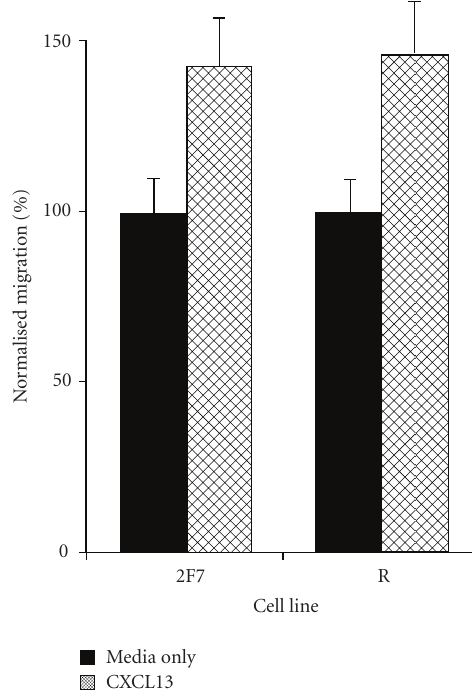
Figure 4: AIDS-NHL cell lines demonstrate chemotaxis towards CXCL13 in vitro. As noted in Section 2, cells of the AIDS-NHL cell lines, 2F7 (AIDS-BL) or R (AIDS-DLBCL), were first prelabeled with Calcein-AM, and then placed on top of 96-well chemotaxis chambers and permitted to migrate for 2 hours in response to CXCL13 or media alone placed in the lower wells. To create a standard curve, preset numbers of cells were added to some wells. Fluorescence in the bottom well was read in a plate reader, and this data was converted to number of cells migrated using the standard curve. As noted in Section 3, 100ng/mL of CXCL13 was used for the 2F7 cell line, and 50ng/mL was used for the R cell line. Each experiment was replicated at least 3 times, and, in each experiment, 6–12 replicate wells were used for each experimental condition. The figure shows data from a representative experiment for each cell line. Results are shown as average percent of cells migrating compared to the media only controls (which are set at 100%). Solid bars show results for media alone controls; hatched bars show results after addition of CXCL13. Bars represent the